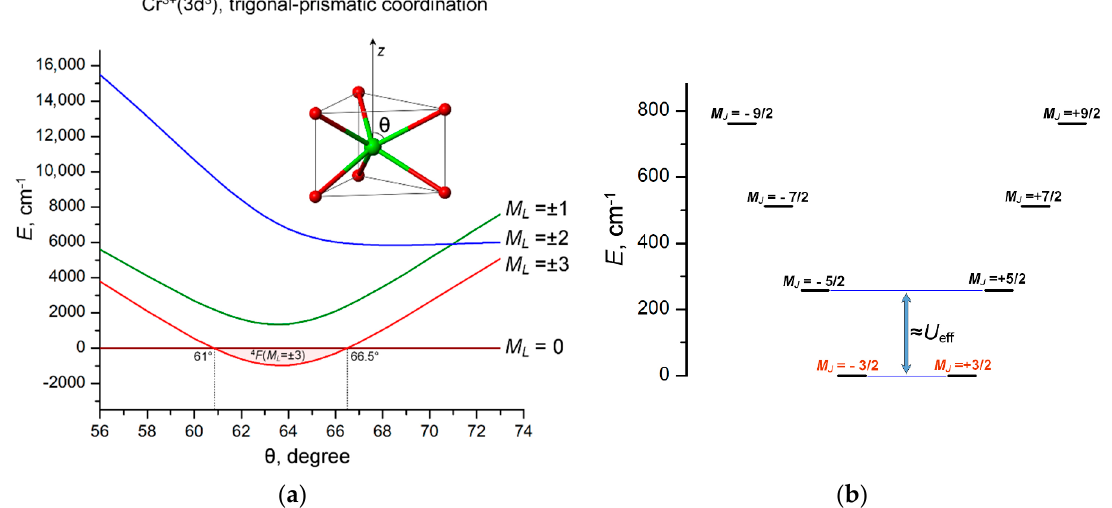
Figure 4. ( a ) Variation of the energies of the 4 F ( M L ) LF states of Cr 3+ (3d 3 ) ion with increasing polar angle θ in a trigonal-prismatic coordination polyhedron. The range of the stabilization of the 4 F ( M L = ±3) ground state (61° ≤ θ ≤ 66.5°) is marked with light pink; ( b ) E vs. M J diagram calculated at θ = 64°. The spin-reversal barrier U eff ≈ 200 = 250 cm − 1 is approximately estimated by the energy separation between the ground M J = ±3/2 and the first excited M J = ±5/2 states.